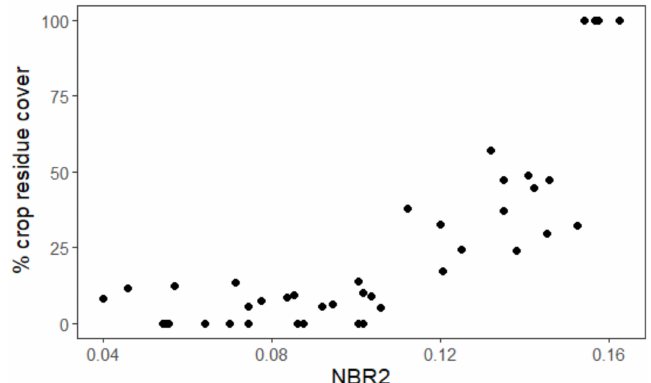
Figure 17. Normalized Burn Ratio 2 (NBR2) calculated on S-2 MSI spectra from 13 October, 2019 plotted against crop residue cover for 59